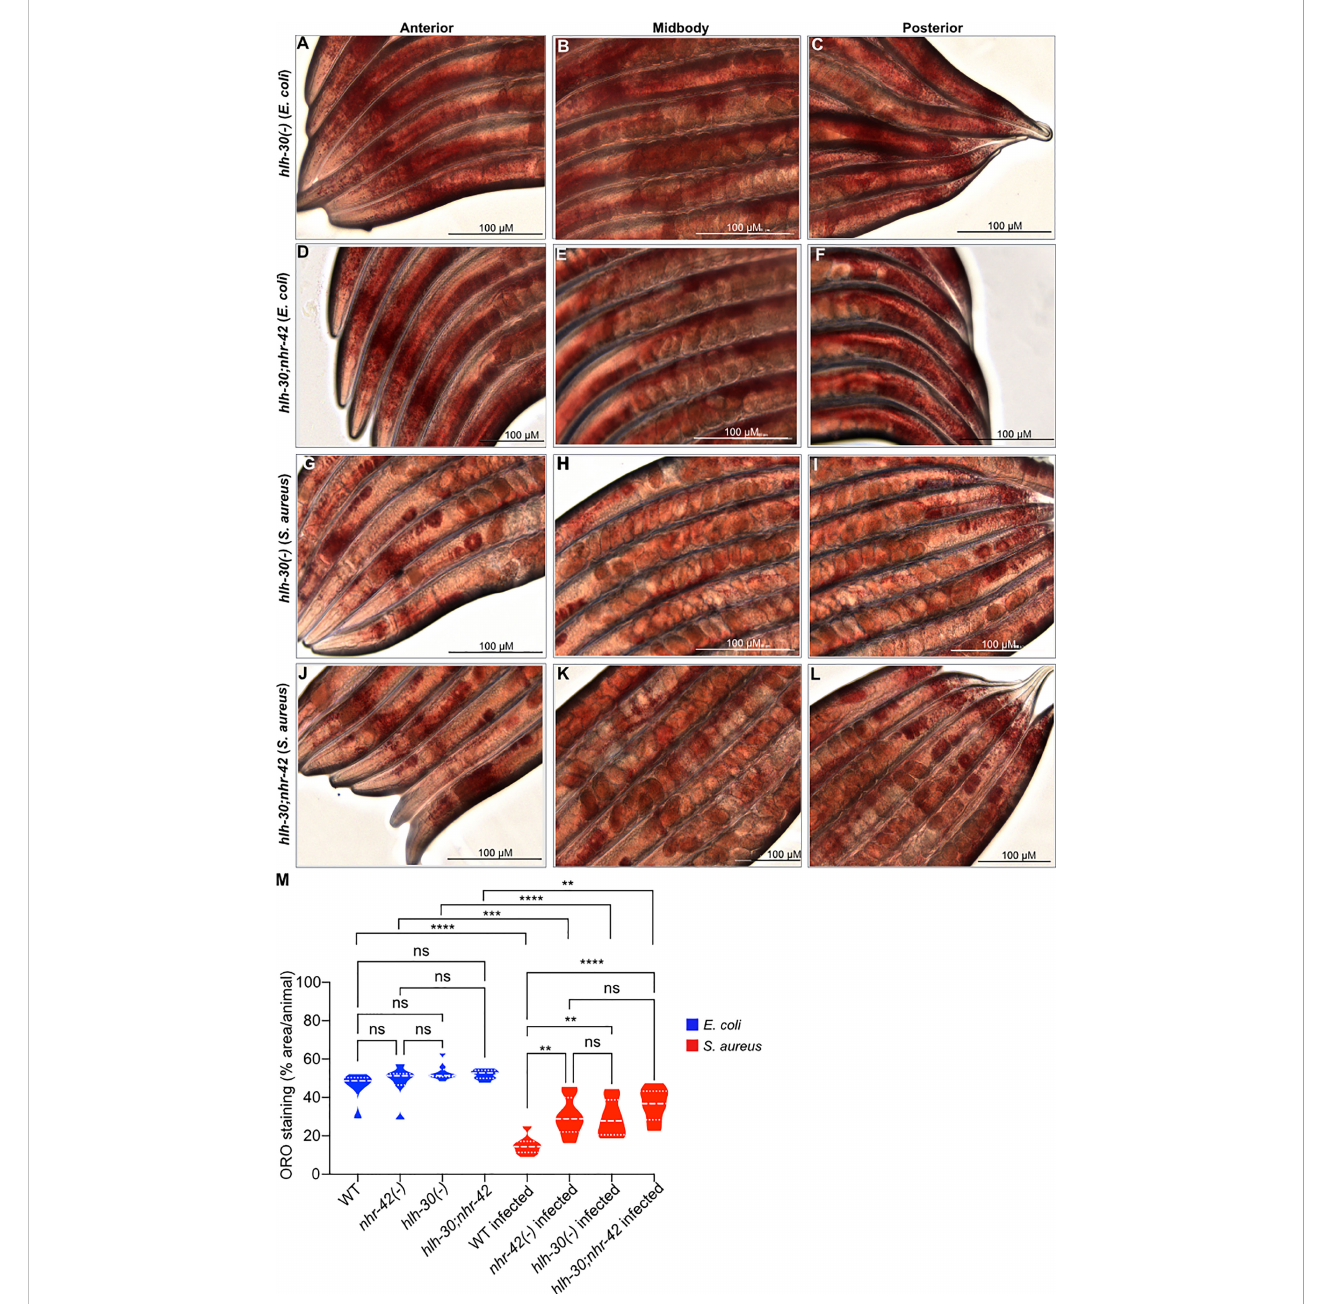
FIGURE 5 Loss of lipid droplets in hlh-30 mutants (A – C) ORO staining of hlh-30 (tm1978) animals fed with E. coli OP50 for 10 h. (D – F) ORO staining of hlh-30 (tm1978)IV; nhr-42 (tm1375)V animals fed with E. coli OP50 for 10 h. (G – I) ORO staining of hlh-30 (tm1978) animals infected with S. aureus SH1000 for 10 h. (J – L) ORO staining of hlh-30 (tm1978)IV; nhr-42 (tm1375)V animals infected with S. aureus SH1000 for 10 h. (M) Quanti fi cation of ORO staining. 7- 10 animals per condition. ** P ≤ 0.01, *** P ≤ 0.001, **** P ≤ 0.0001. ns, not signi fi cant. One-way ANOVA with S ̌ ı ́ da ́ k ’ s post-hoc